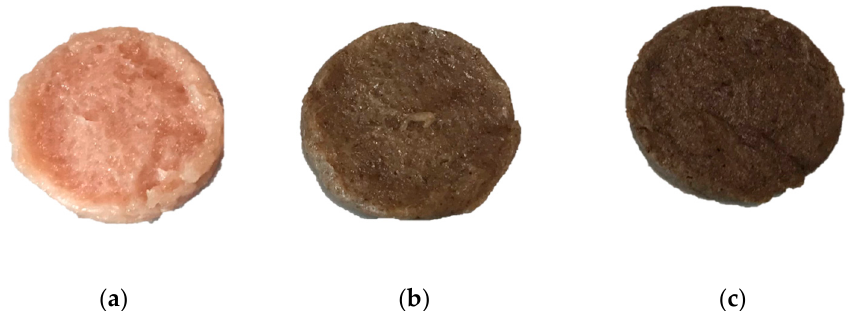
Figure 1. Uncooked burgers of the three experimental batches: ( a ) control (CTRL) without CSS additions; ( b ) with addition of +1.5% of coffee silver skin (CSS 1.5%); ( c ) with +3.0% of coffee silver skin (CSS 3.0%).